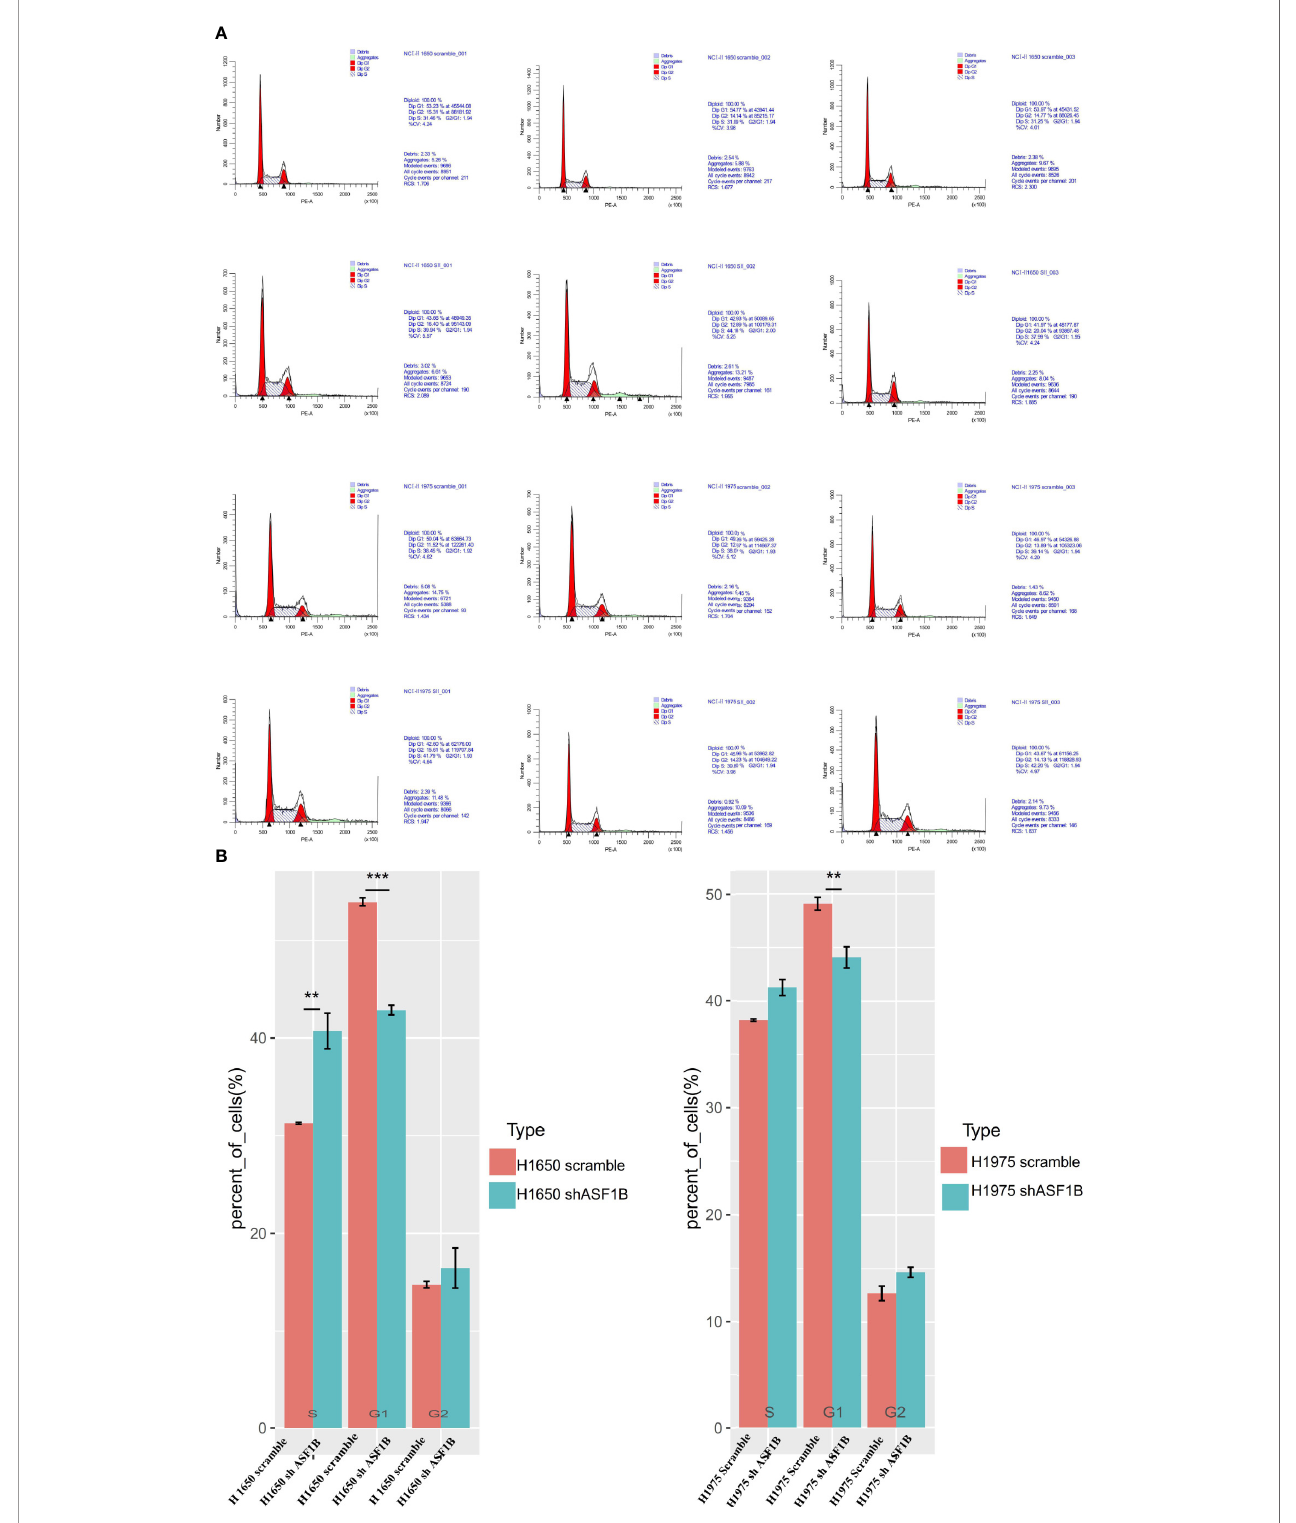
FIGURE 8 | ASF1B knockdown in fl uence the cell cycle. (A) Flow cytometry was used to detect the cell cycle changes in H1975 and H1650. (B) Accumulated analysis of the cell cycle. **p vaule ≤ 0.01; ***p vaule ≤